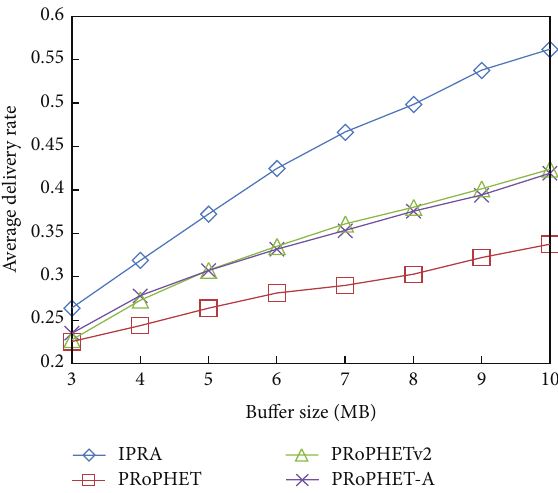
Figure 7: Average delivery rate (ADR) versus buffer